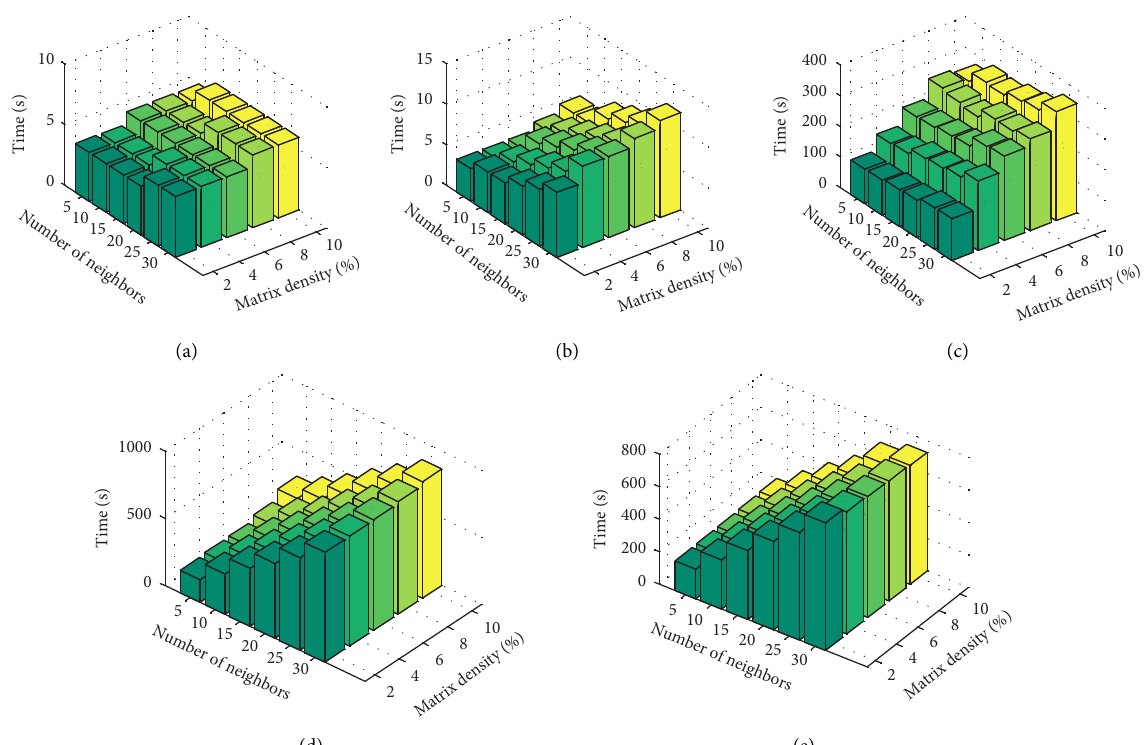
Figure 5: Execution time: (a) CF, (b) RB ( k � 4), (c) DB, (d) MB, and (e)